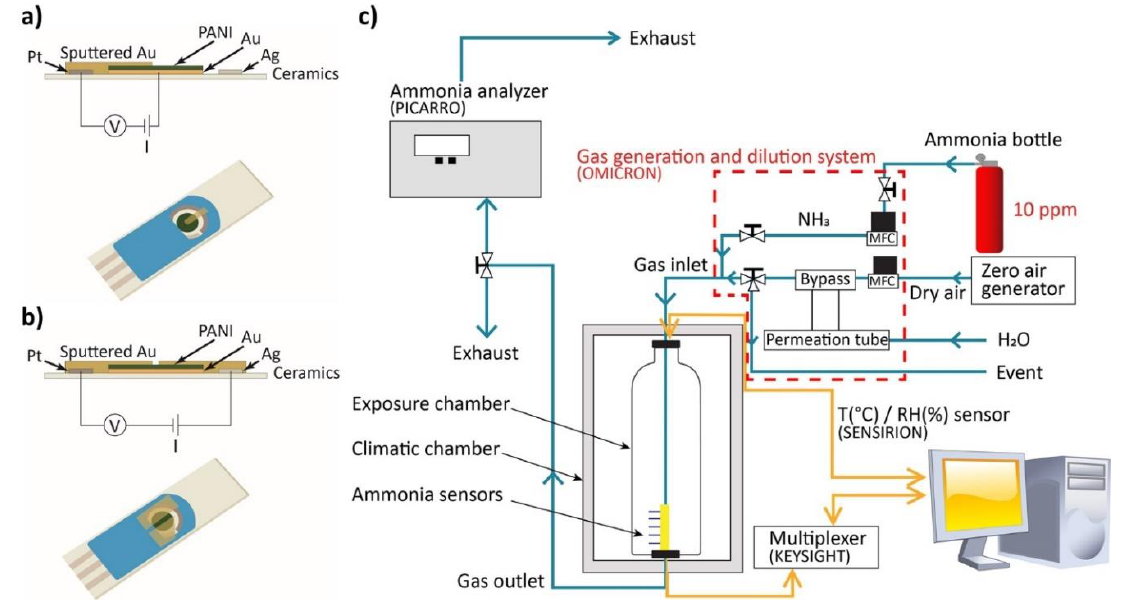
Figure 2. ( a ) Scheme of connection 1; ( b ) scheme of connection 2; ( c ) schematic view of measurement system for sensing.